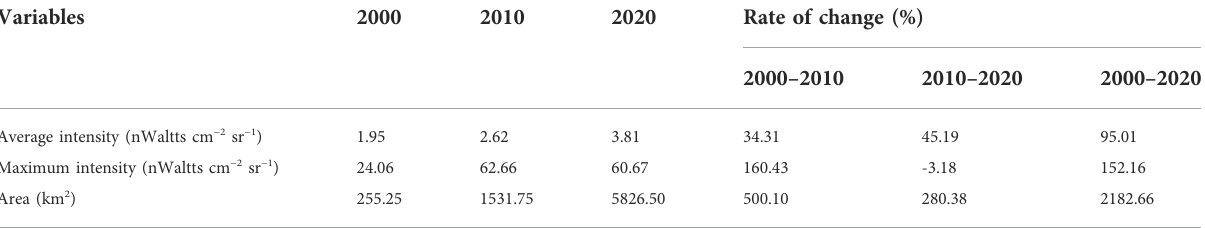
TABLE 3 Nighttime light intensity and ranges in giant panda distribution